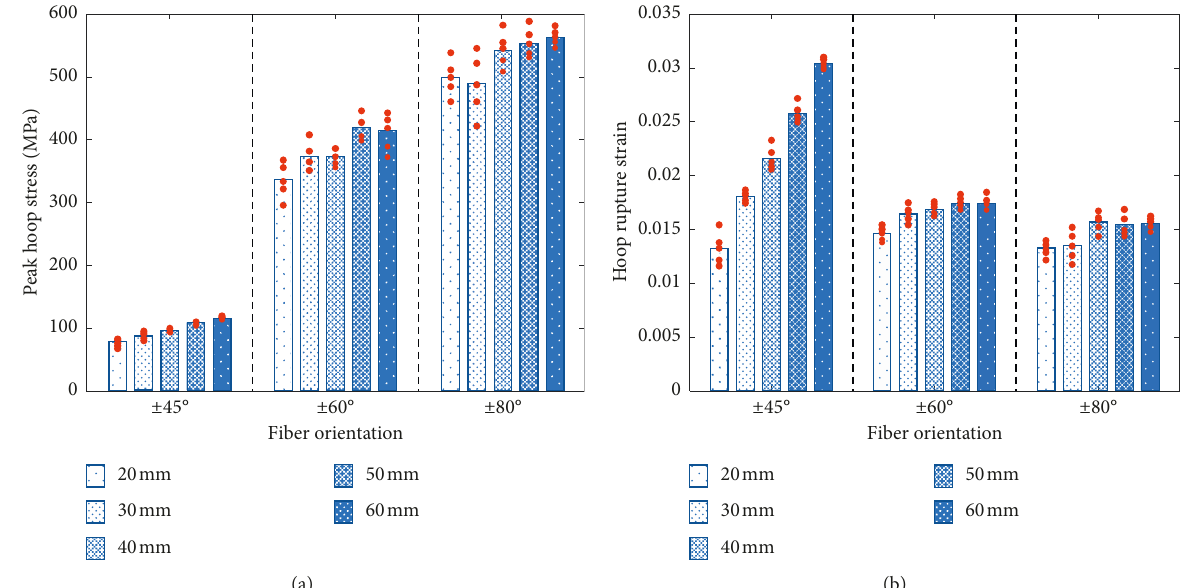
Figure 6: Effect of FRP ring width. (a) Peak hoop stress. (b) Ultimate hoop